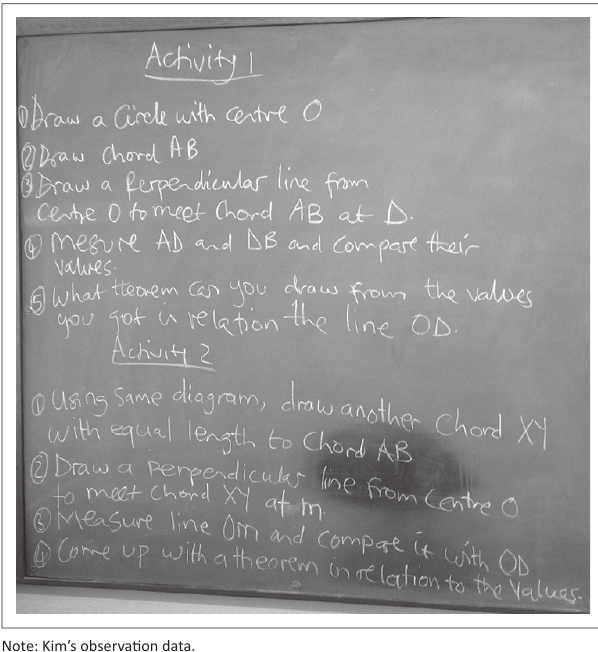
Note: Kim’s observation data. FIGURE 4: Empirical exploration tasks on chord properties of the circle.